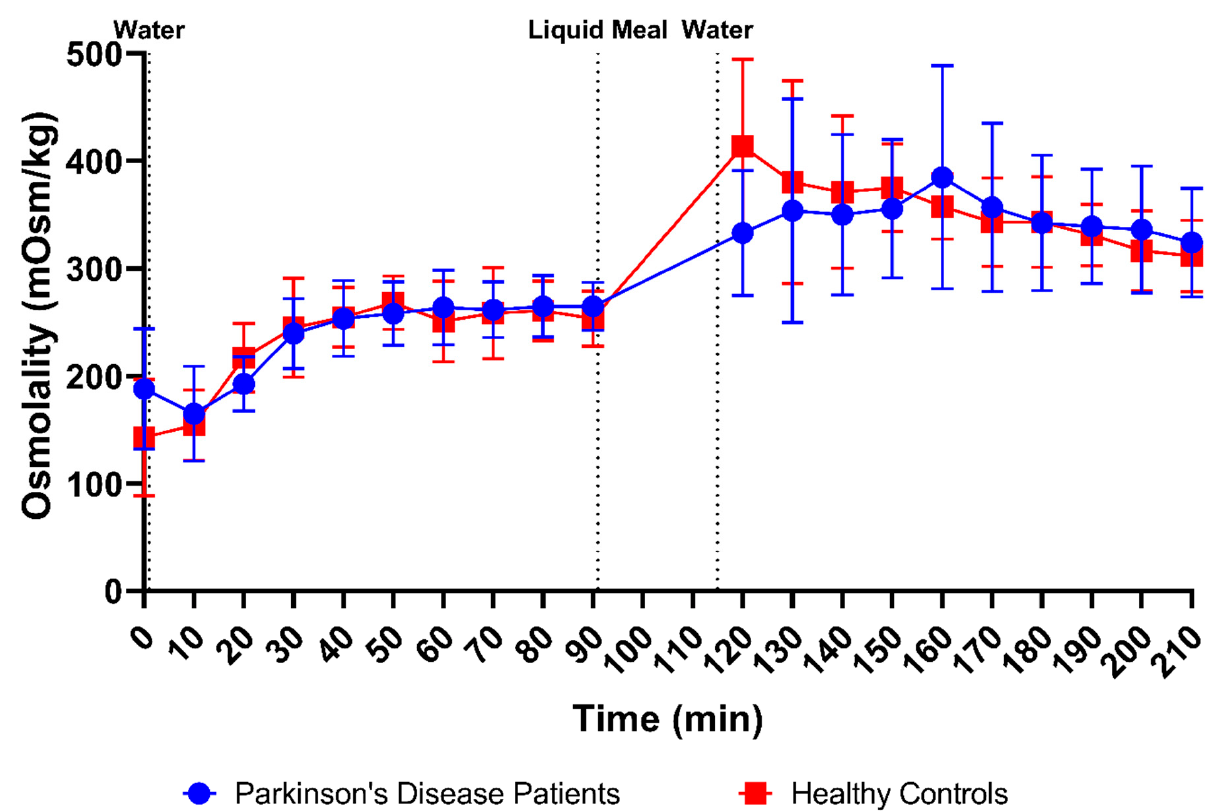
Figure 6. Time-dependent evolution of the osmolality in duodenal fluids aspirated from Parkinson’s disease patients ( n = 9, blue circles) and healthy controls ( n = 9, red squares). Data points represent the mean ± standard deviation; vertical dotted lines indicate the ingestion of 100 mL of water or 200 mL of liquid